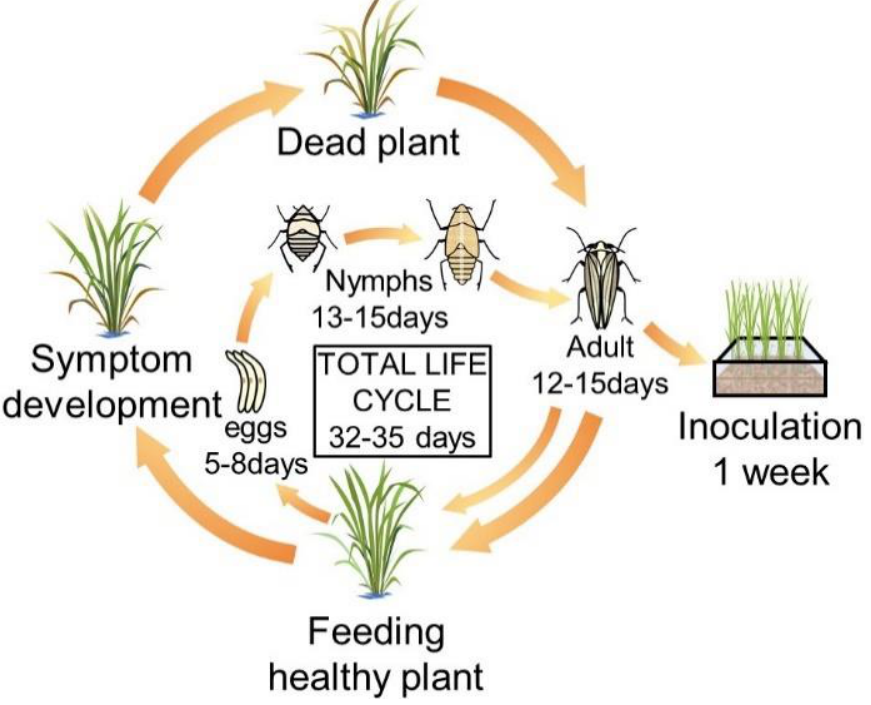
Figure 1. Breeding system and life cycle of the white-backed plant hopper (WBPH). In the breeding cage, healthy rice at the seedling stage was provided as food for the white-backed plant hoppers (WBPHs) every week. The WBPH hatches from eggs after 5 – 8 days and has a nymph period of 13 to 15 days. After that, it becomes an adult and is active for 12 – 15 days. At this time, if new food is provided, the adult insects move to the new food. The total life cycle of the WBPH is 32 to 35 days, and the sucked rice turns yellow and dies over time.